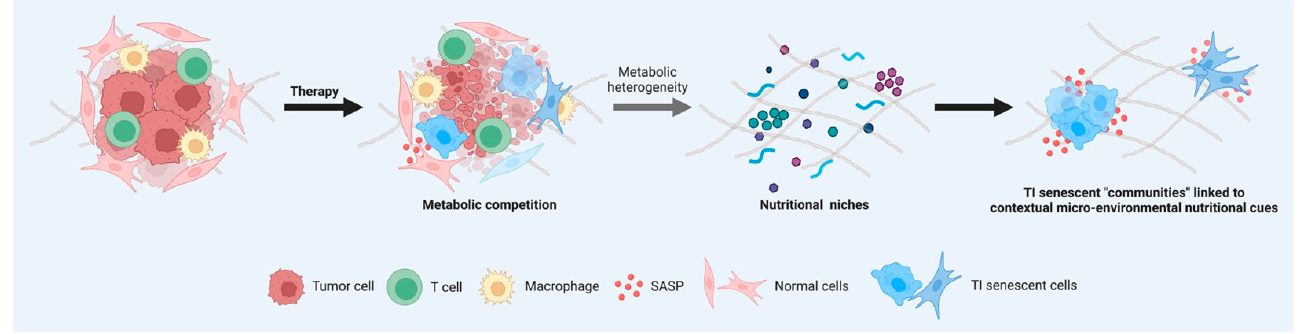
Figure 5. Nutritional fingerprints of therapy-induced senescent cells: linking senescent pheno- types to metabolic niches. Cells in a TIS state share several common features, such as changes in morphology, increase in β -galactosidase activity, and activation of an inflammatory response. Un- derstanding whether all types of senescent cells induced by exogenous therapeutic stresses are iden- tical or heterogeneous in terms of their metabolic needs might aid in achieving the goal of selectively eliminating the deleterious effects of TIS cells. The recognition of inter-TIS heterogeneity in terms of scavenging and catabolic ability contingent on nutrient availability might help to molecularly un- derstand and therapeutically exploit TIS phenotype-associated “communities” linked to contextual micro-environmental nutritional cues in complex cancer and normal tissues. Glucose 1-phosphate, a key intermediate of the glucuronic acid pathway involved in the conversion of galactose to glucose, synthesis of glycogen and glycosaminoglycans, and metabolism and clearance of chemotherapeutic drugs via glucuronosylation [82–86], was differentially employed by doxorubicin- and palbociclib-induced senescent cells. The non-adenosine nucleosides, inosine and uridine, were exclusive nutritional sources for senescent cells induced by the DNA-damaging drugs bleomycin and doxorubicin. Extra- cellular inosine has recently been shown to relieve tumor-imposed metabolic restrictions on T-cells by operating as an alternative substrate for cell growth and function of effector T-cells in the absence of glucose [87]. Extracellular uridine has been shown to rescue nu- trient stress (glucose deprivation) in astrocytes and neurons [88,89], and was more re- cently reported to be a compensatory metabolite in pancreatic cancer cells growing under nutrient-deficient conditions [60]. The ribose moiety of inosine and uridine can be used as a carbon source for central metabolic pathways, providing not only biosynthetic precur- sors for anabolic proliferation (e.g., via nucleotide salvage), but also fueling energetic me- tabolism via routing through the pentose-phosphate pathway and subsequent oxidative catabolism [60,87]. The upregulation of nucleoside usage in diverse cell types including immune, cancer, and now TIS cells, indicates that metabolic competition impacting both immunosuppression and tumor progression might occur in interstitial tumor fluid where uridine levels are highly enriched (up to millimolar levels) relative to their levels in serum [51]. Notably, suppression of nucleotide synthesis, particularly that of pyrimidines such as uridine, is a critical metabolomic adaption that plays a causative role in the establish- ment of replicative- and oncogene-induced senescence [90,91]. Moreover, exogenous uri- dine has recently been described as a pro-regenerative metabolite capable of reducing physiological and pathological stem cell senescence and promoting tissue regeneration and repair [92]. As TIS is not necessarily detrimental, the ability of DNA damage-induced senescent cells to utilize nucleosides for cellular energetic needs in the absence of suffi- cient glucose might be understood in terms of facilitating repair (including DNA repair) in tissues injured by cancer therapy [93–95]. Although we recognize the limitations of ex- trapolating our in vitro findings with a lung adenocarcinoma cell line to TIS in normal tissues, the senescence response of A549 cells to DNA damage agents such as bleomycin was not very different from that observed in normal alveolar epithelial cells [61]. Delayed induction of miR146a is a compensatory response that restrains the pro-in- flammatory expression and secretion of IL-6/IL-8 driven by the robust activation of the IL-